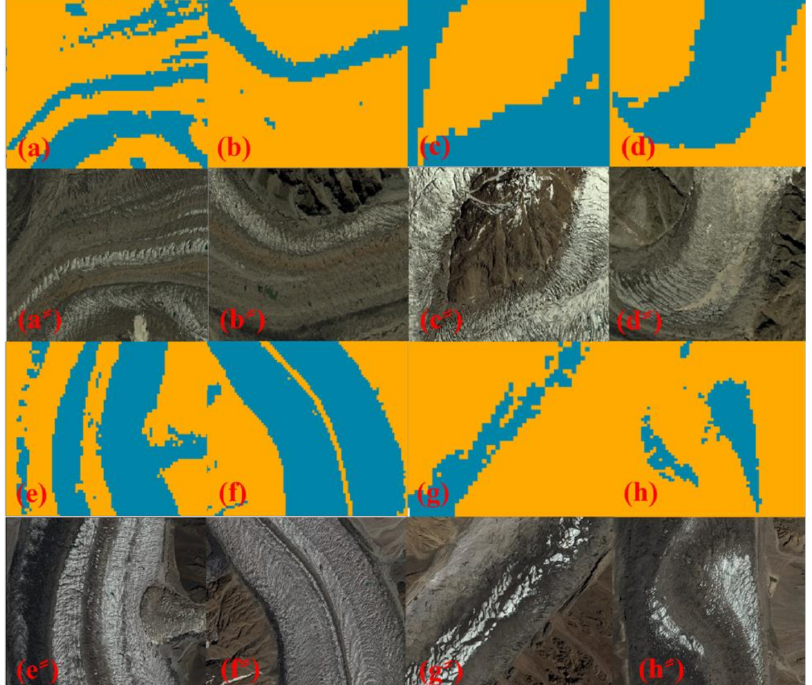
Figure 9. The images show the accuracy of NDSI compared to SPOT 7 high-resolution images; ( a – h ) NDSI classified patches from Landsat data, with blue color showing clean ice and yellow color showing debris-covered ice; ( a ”– h ”) SPOT 7 high-resolution patches of the same area, with darker color showing the debris-covered ice and white color showing clean